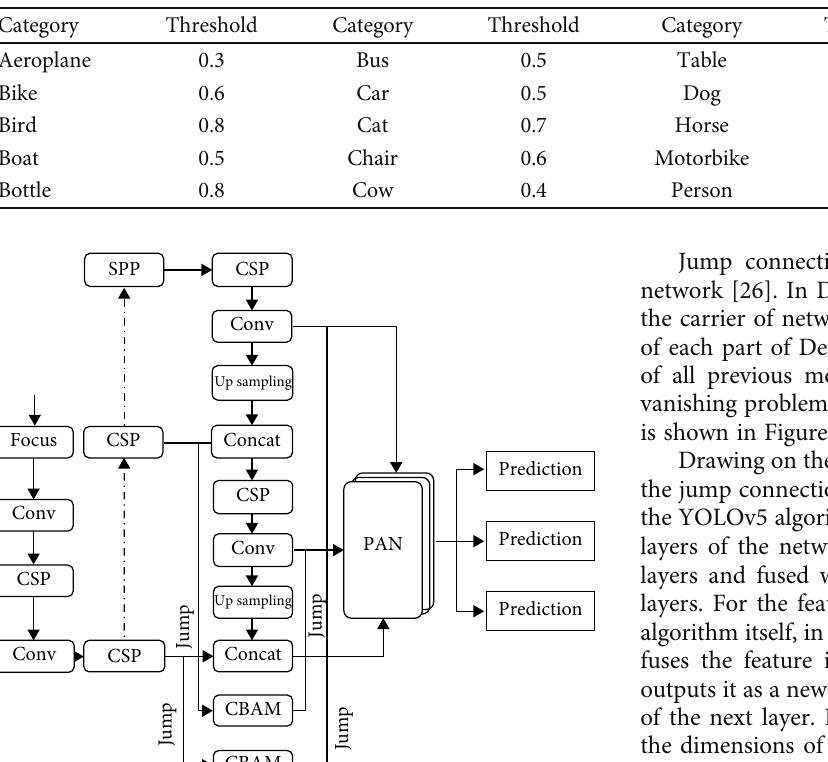
Table 1: Binarization thresholds for PASCAL VOC dataset.